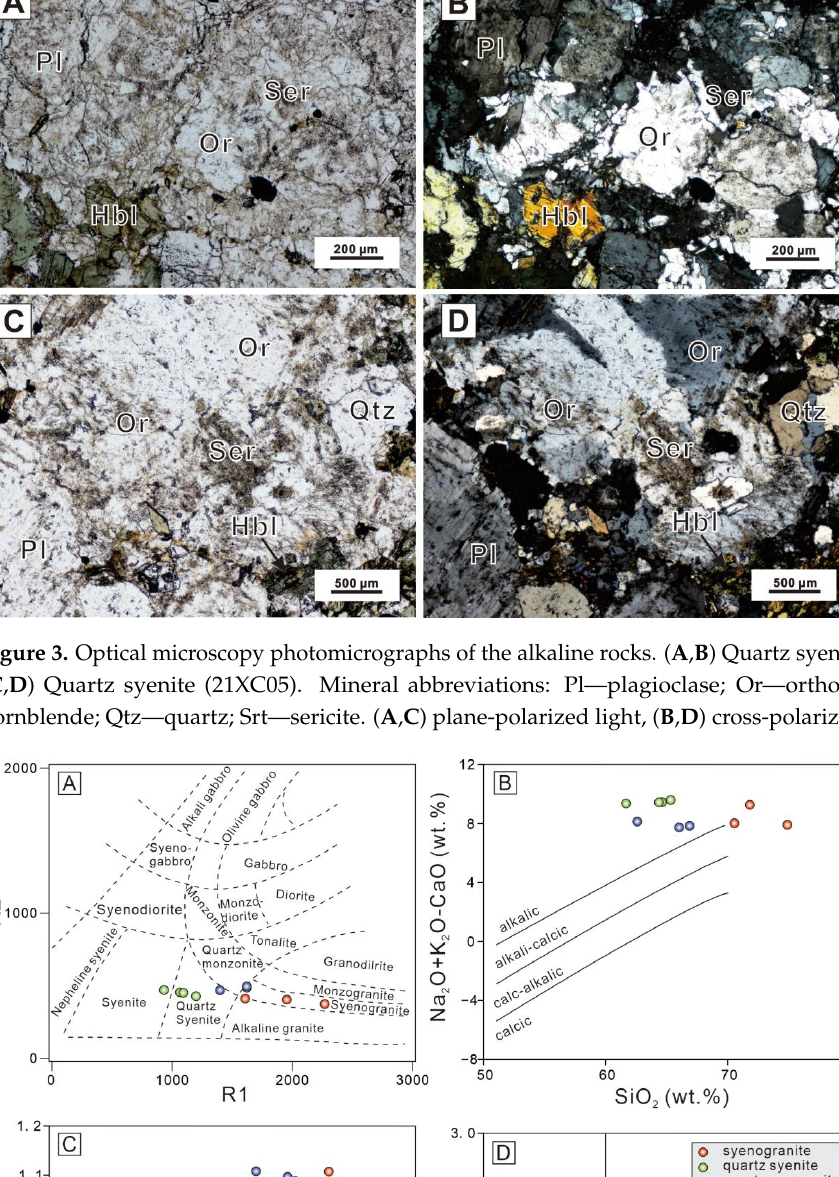
Figure 5. ( A ) Chondrite ‐ normalized REE patterns [36]; ( B ) Primitive mantle ‐ normalized trace ele ‐ ment patterns [37].